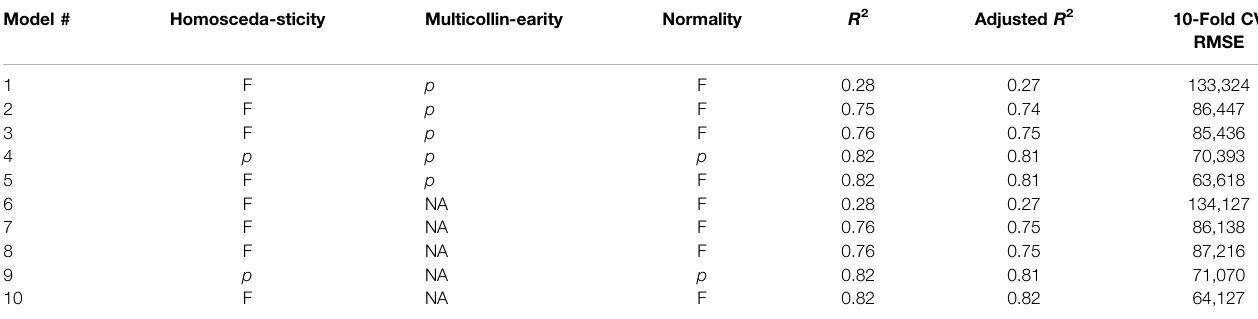
TABLE 5 | Model evaluation results for multiple regression models. Model